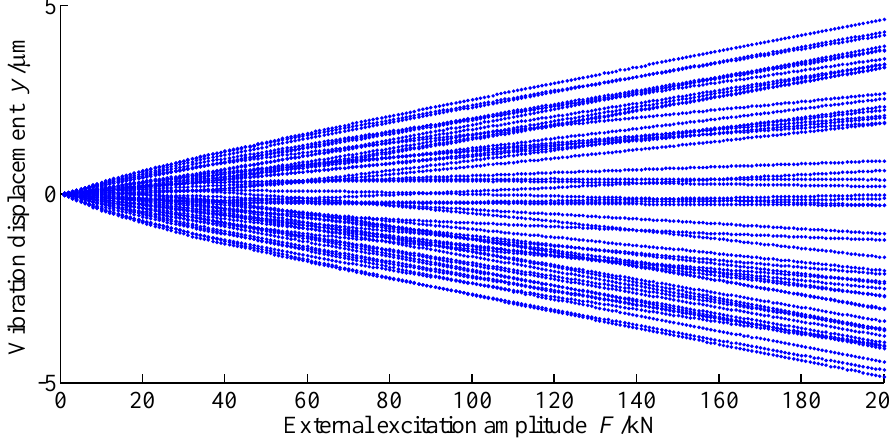
Figure 9. Bifurcation diagram with the variation of F .